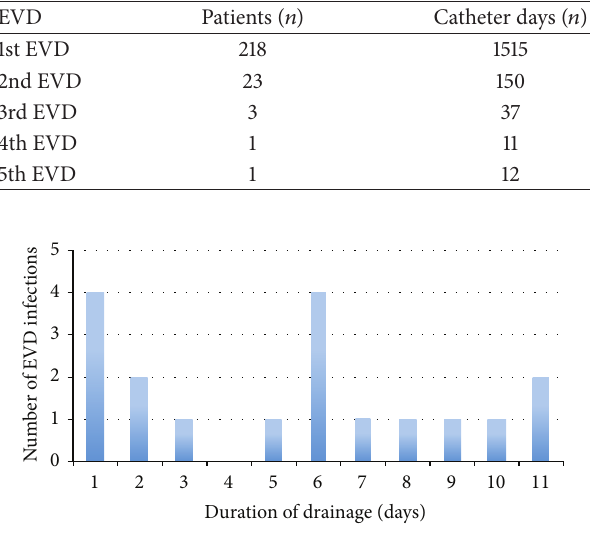
Figure 1: Occurrence of EVD-related infection related to drainage days after placement of EVD with underlying